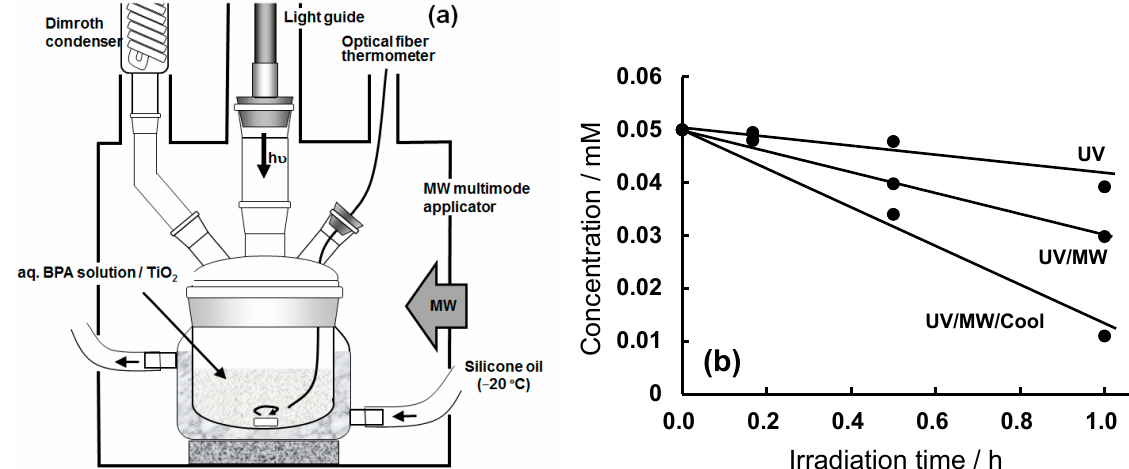
Figure 6. ( a ) Schematic illustration of the microwave-assisted photoreactor (MPR) coupled to a cooling system in the microwave multimode applicator; ( b ) Temporal decrease of the concentration of bisphenol-A (BPA: 0.050 mM) during its decomposition in aqueous media by photoassisted oxidation (UV), by the microwave-/photo-assisted oxidation (UV/MW) method, and by the integrated microwave-/photo-assisted degradation under cooling conditions (UV/MW/Cool). Reproduced from [38]. Copyright 2007 by Elsevier